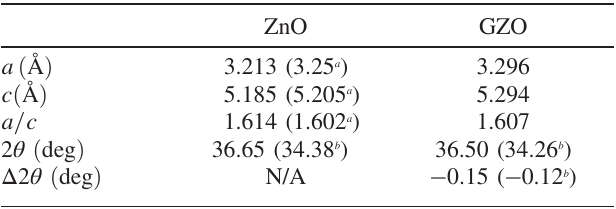
TABLE III. Calculated and measured (in parentheses) lattice parameters of bulk ZnO and GZO.